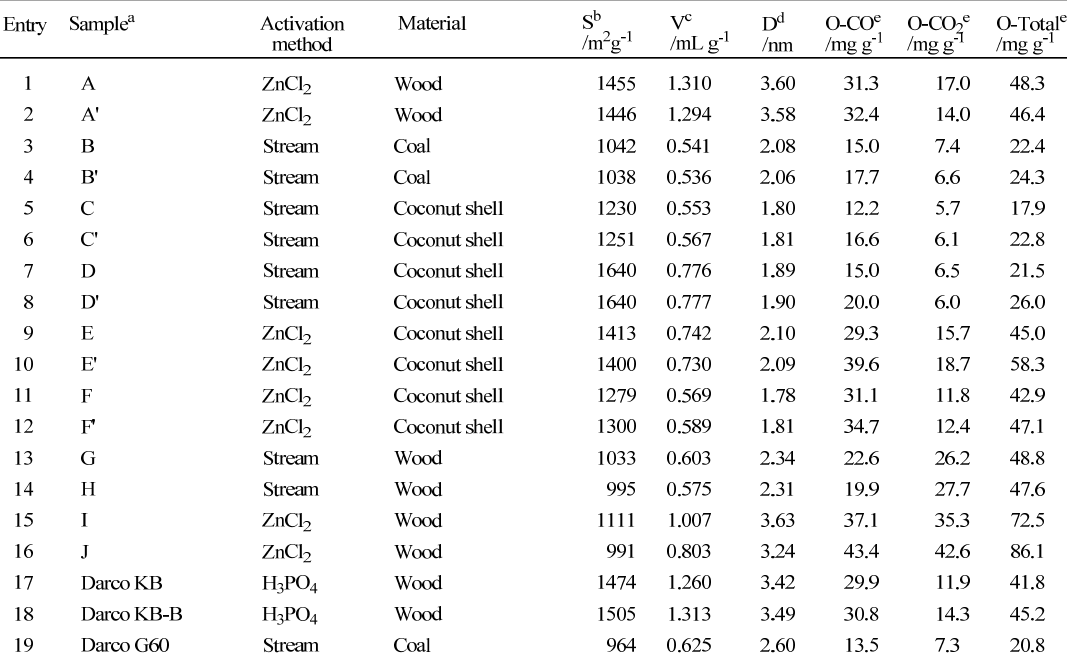
Table 9. Properties of activated carbons.